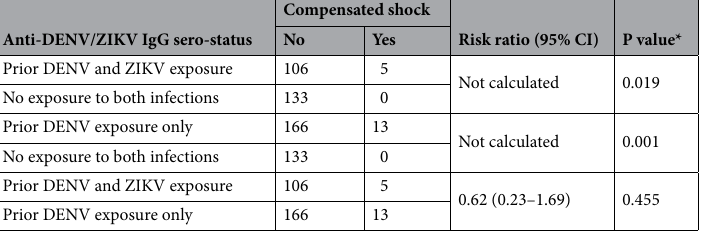
Anti-DENV/ZIKV IgG